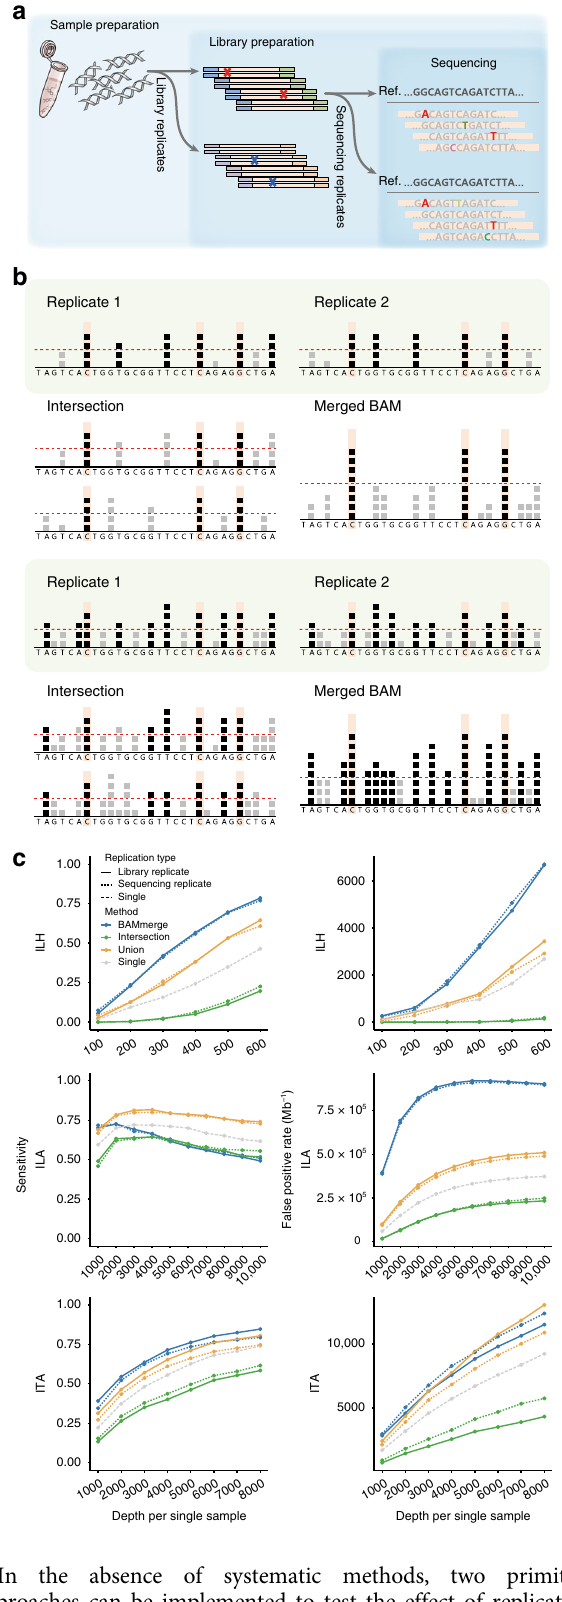
(Fig. 2b and Methods). The intersection model is based on the reproducibility of variants. Thus, only variants that are called in every replicate are fi nally reported. The intersection model can be